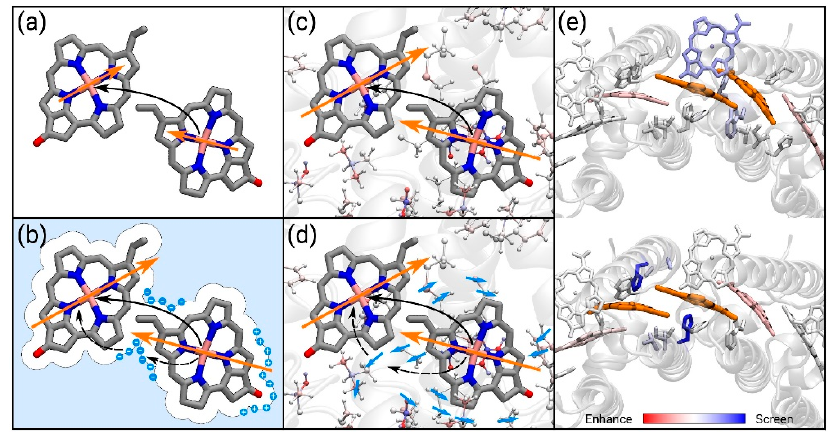
Figure 6. ( a ) Electronic coupling computed in vacuo. The interaction is between the two transition dipoles. ( b ) Electronic coupling computed in a polarizable continuum scheme. The transition dipoles are enhanced by the environment and, in addition to the dipole–dipole interaction (solid arrow), there is an interaction through the environment (dashed arrows). ( c ) Electronic coupling computed in a MM electrostatic embedding. The transition dipoles are enhanced by the environment, but there is no screening effect. ( d ) Electronic coupling computed in a MM polarizable embedding (MMPol). The transition dipoles are enhanced and there is an interaction through the environment. ( e ) Effect of the polarizable environment on two non-equivalent electronic coupling of the LH2 (blue: Screening, red: Enhancing). Note how the histidines coordinating the BChls reduce the second coupling while they do not affect the first. Reprinted with permission from [68]. Copyright (2020) Elsevier.